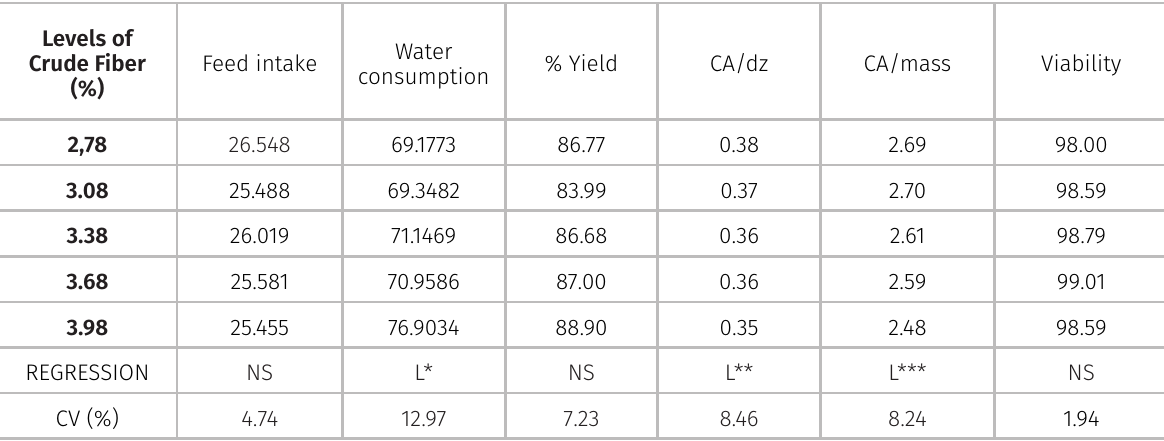
Table II. Feed consumption (g), water consumption (mL), percentage of egg yield (% yield), feed conversion per dozen eggs (CA/dz), feed conversion per egg mass (CA/mass) and viability (%) of Japanese quails fed diets containing different levels of crude